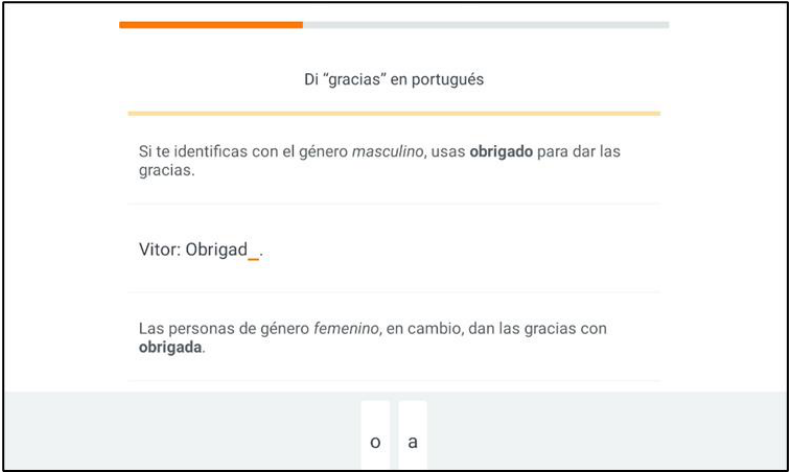
Figure 3. Topic explanation activity for Lesson 1.